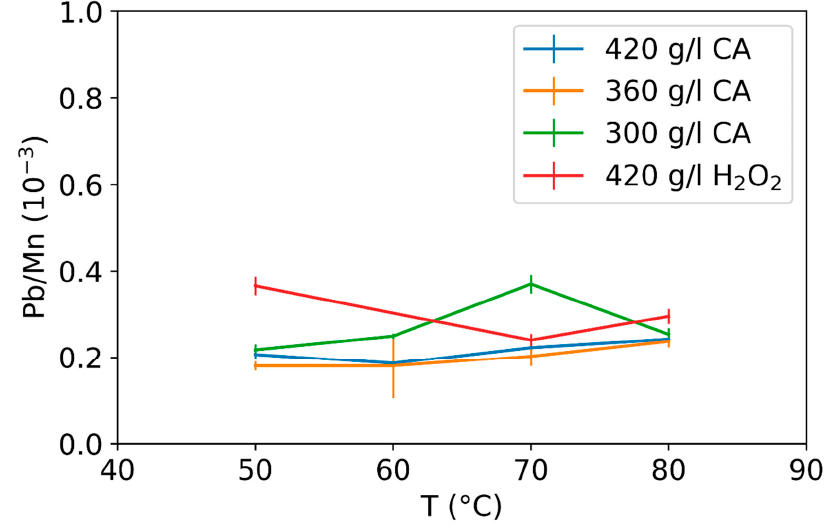
Figure 9. Effect of S/L and temperature on calcium (g/L) to manganese (g/L) ratio after 180 min of reaction time.